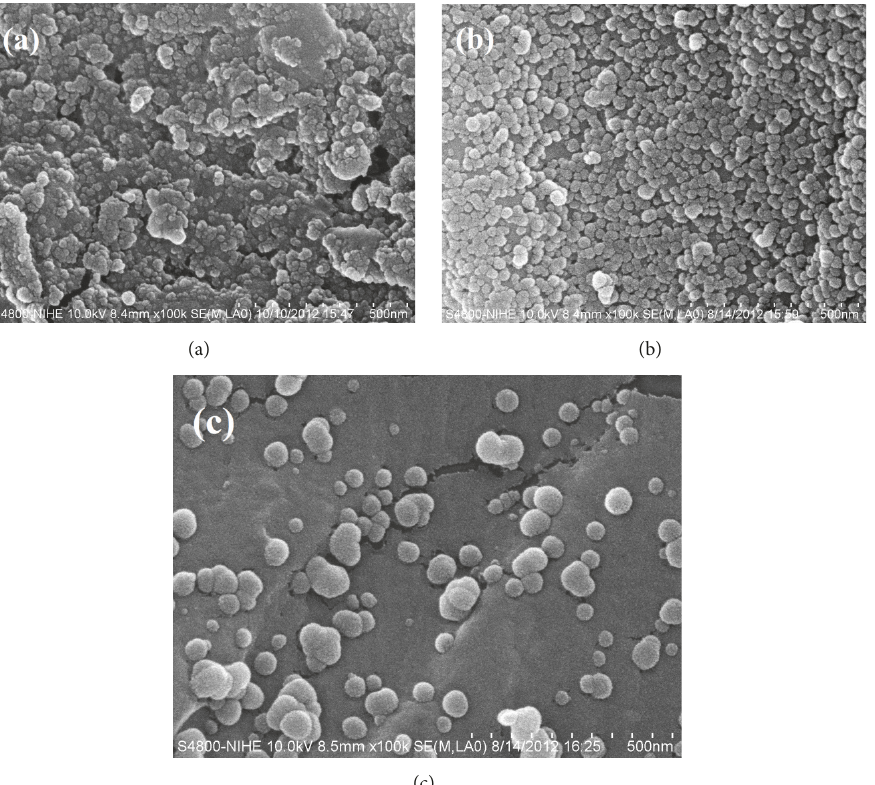
Figure 4: FESEM images of (a) WS1, (b) WS5, and (c) WS10.